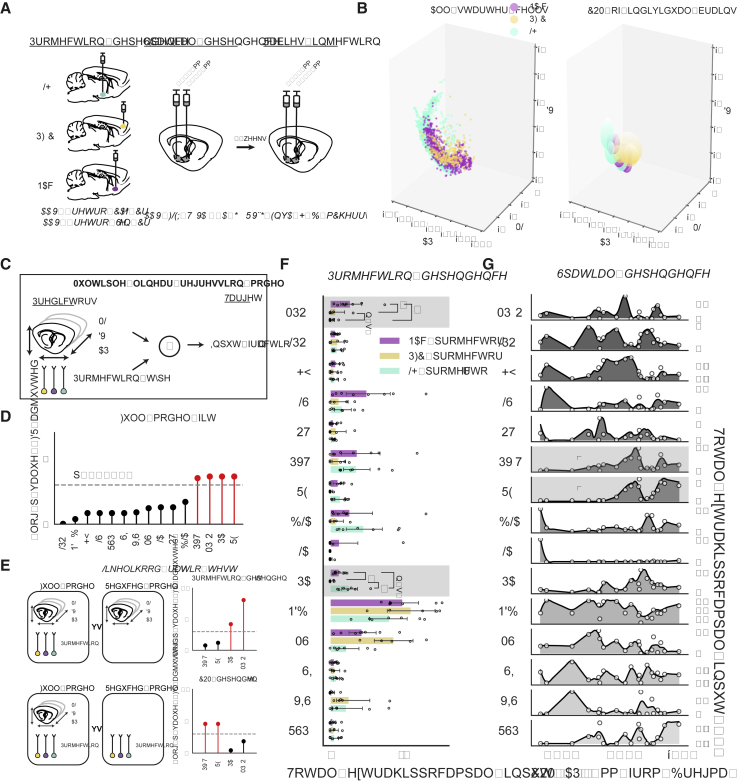
TRIO of vS Output Neurons Reveals Projection and Spatial Bias of Inputs(A) Schematic of TRIO protocol for assessing projection (via retro-Cre injection in the output site) and spatial dependence (via varying AP injection sites of TVA-G and rabies) of inputs.(B) 3D scatterplots (left) and geometric COM of individual brain samples (right) of starter cells. COM of individual brains are represented as ellipsoids (center defined as the mean position and radii as 1 standard deviation of the cell distribution in AP, ML, and DV). The spatial distribution of starter cells along the three brain axes was comparable (standard deviation of COM: AP = 0.23 mm; ML = 0.19 mm; DV = 0.28 mm).(C) Schematic of linear regression analysis. Linear models were constructed with COM (in all three brain axes), and output type as independent variables and the extrahippocampal input fraction (log-transformed) as the dependent variable (n = 20 brains).(D) Full model fits assessed by computing the F-statistic of full models with COM and projection as predictors. Inputs from PVT, MPO, PA, and RE (red) exceed the threshold of p = 0.05 after correction for multiple comparisons.(E) Likelihood ratio tests (see STAR Methods) show that MPO and PA inputs are projection dependent, whereas PVT and RE are spatially dependent. p values have been corrected for all 15 input regions tested, but only the significant hits shown in (D) are illustrated. Dashed lines indicate p = 0.05.(F) Quantification of extrahippocampal inputs. The number of inputs from a brain region is expressed as a percentage of the total number of extrahippocampal inputs (vSNAc: n = 8 brains; vSPFC: n = 5 brains; vSLH: n = 7 brains). Shaded boxes indicate projection-dependent input regions with significant model fits, followed up with post hoc pairwise Tukey multiple comparisons (∗p < 0.05). See also Video S2. Data are summarized as mean ± SEM.(G) Same dataset as in (E) where the input fractions are plotted as a function of COM along the AP axis. Shaded continuous line represents smoothed input density. Inputs from RE and PVT (∗) resulted in a significant model fit with a statistically significant COM AP coefficient.See also Figures S2 and S3 and raw cell count data in Tables S1 and S2.Video S2. Rotating 3D Whole-Brain Views of Rabies-Labeled Inputs Registered to the Allen Brain Atlas, Related to Figure 3Example data for each condition (vSPFC, vSNAc, and vSLH TRIO in posterior and anterior locations) illustrated as rotating virtual glass brains. Each dot represents one rabies-labeled input neuron.